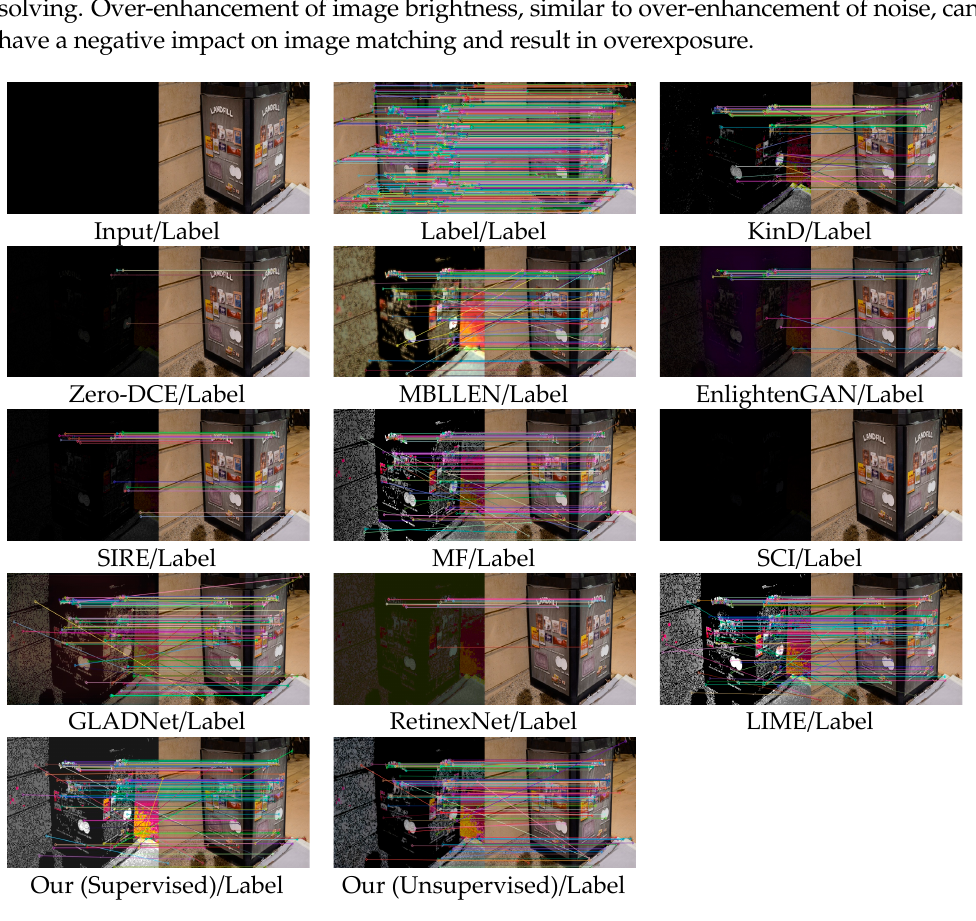
Figure 12. Visualization of image matching results enhanced by different algorithms. Table 5. Comparison of image matching results enhanced by different algorithms.